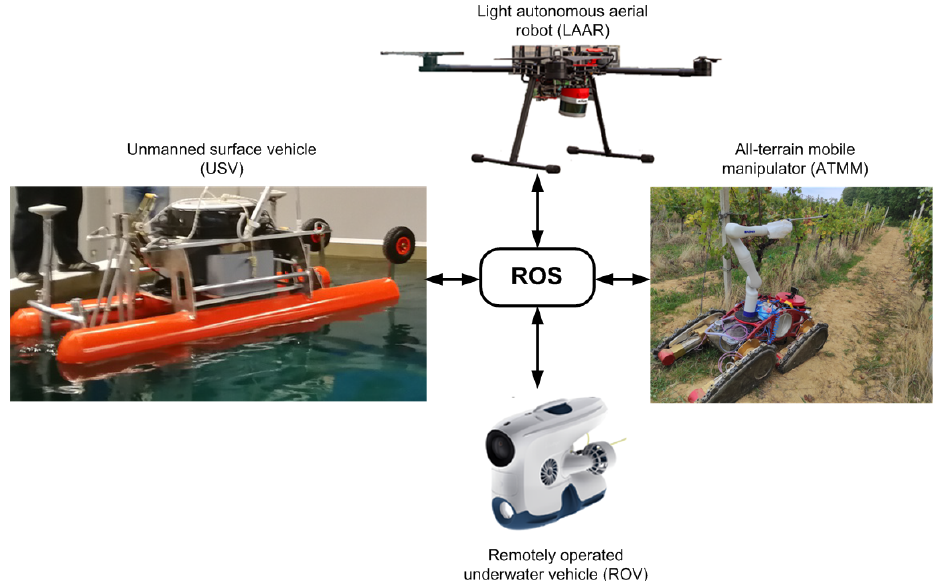
Figure 16. HEKTOR system overview. All software development is based on the use of